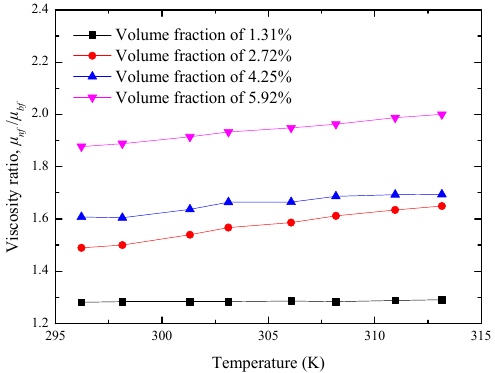
Figure 12. Variations of µ nf / µ bf with temperature for different nanoparticle volume fractions of Al 2 O 3 -water nanofluids.